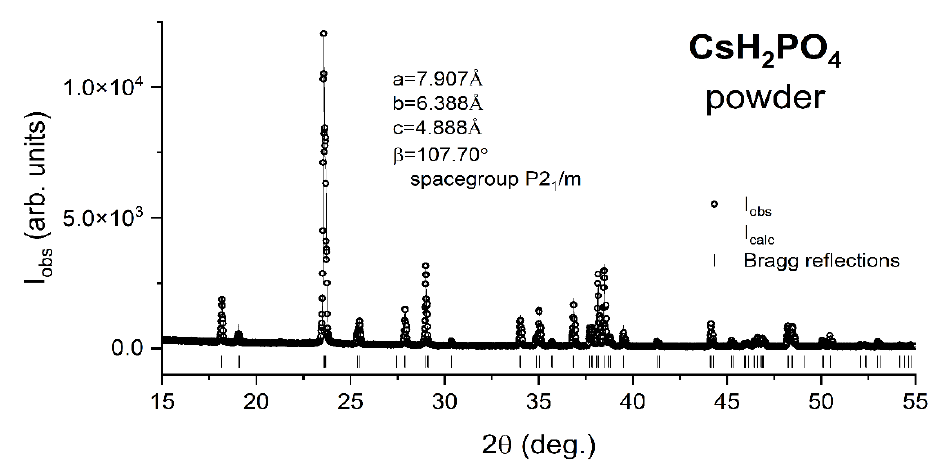
Figure 1. Le Bail (full profile) fit to X-ray diffraction data collected on the prepared CDP powders. The empty symbols show the observed intensity as a function of the detector angle 2θ and the solid line is the fit. The vertical bars mark the positions of the Bragg reflections from CDP’s room temper- ature monoclinic P2 1 /m unit cell of parameters a = 7.907 Å , b = 6.388 Å , c = 4.888 Å , and β = 107.70°. monoclinic P2 1 /m unit cell of parameters a = 7.907 Å, b = 6.388 Å, c = 4.888 Å, and β = 107.70